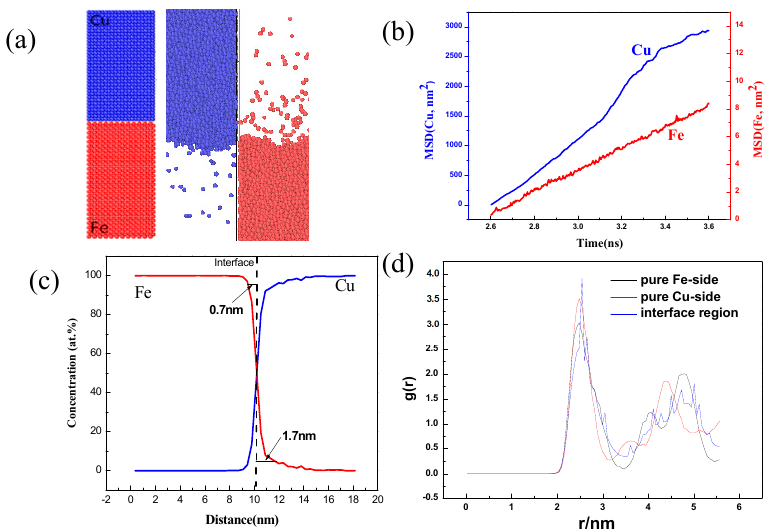
Figure 5. Molecular dynamics simulation results of the Fe/Cu interface: ( a ) initial model and optimised model, ( b ) mean square displacement (MSD) of the Fe and Cu side at 1523 K, ( c ) concentration of the interface Fe and Cu atoms, and ( d ) radial distribution function (RDF) of the Fe/Cu interface at 1523 K.